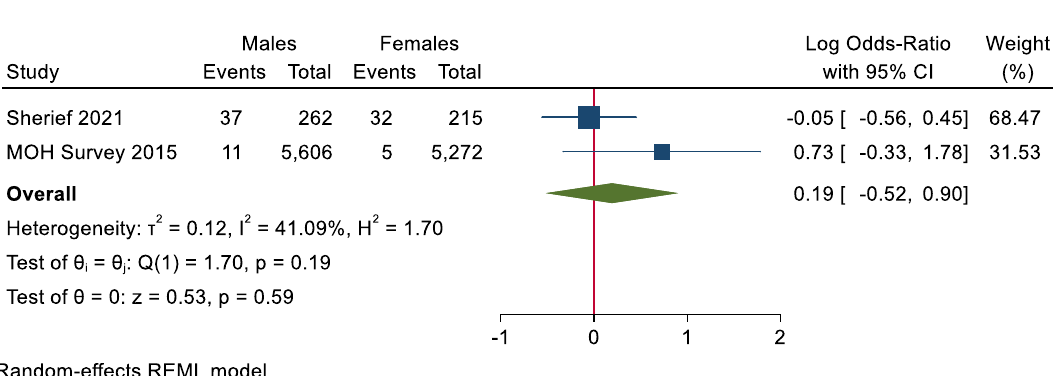
Figure 5. Forest plot of prevalence of HCV RNA in males and females in children. There is no significant difference between males and females in HCV RNA prevalence in